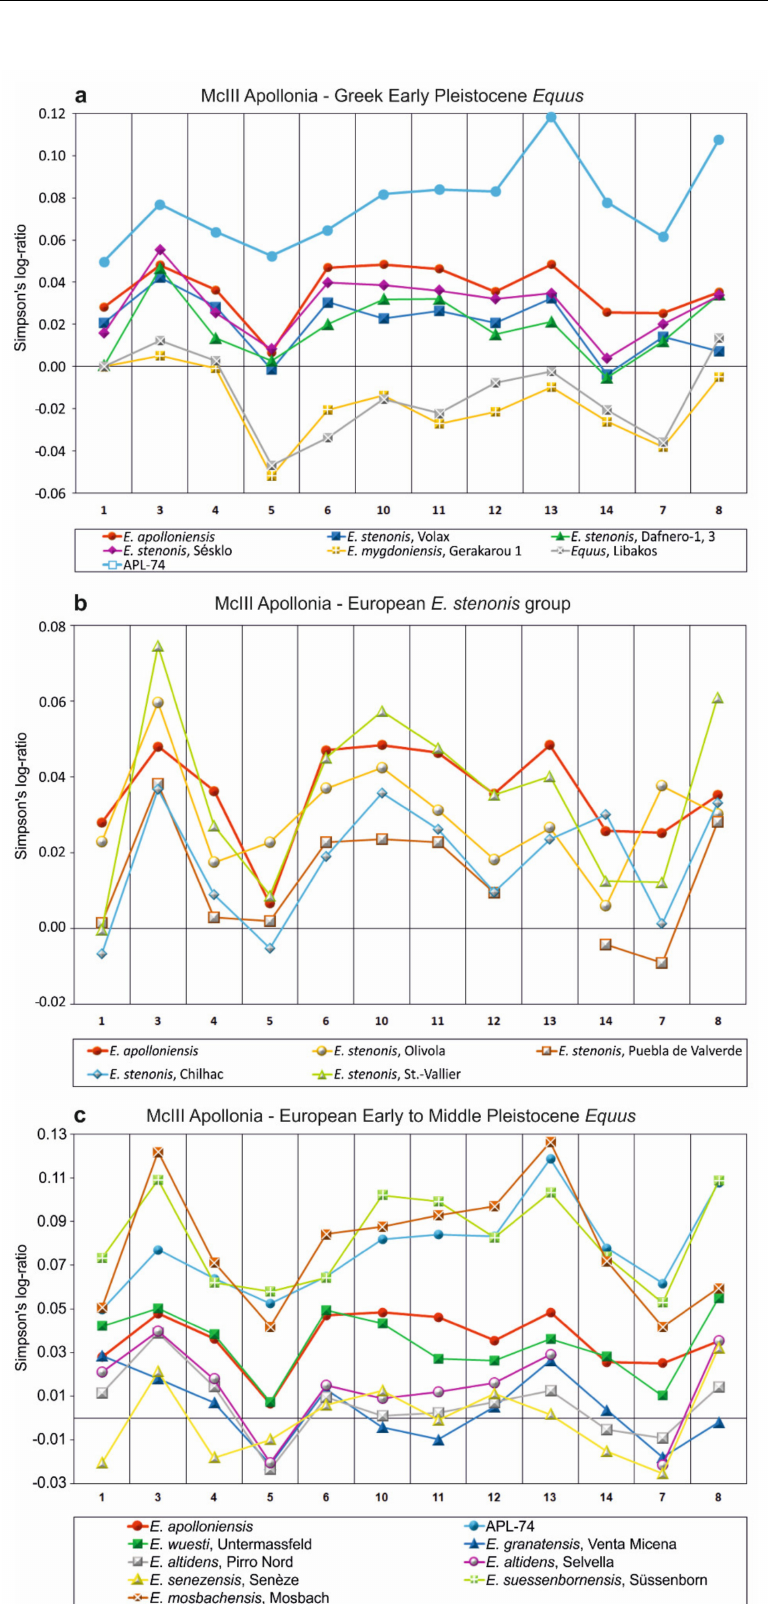
Figure 9. Simpson’s log-ratio diagrams comparing the dimensions of the third metacarpal of E. apol- loniensis with ( a , b ) Greek and European E. stenonis ( c ) and other Early/Middle Pleistocene horses. Standard: Equus grevyi [69]. Data from [61–65,76] and personal dataset. For definitions of meas., see Supplementary